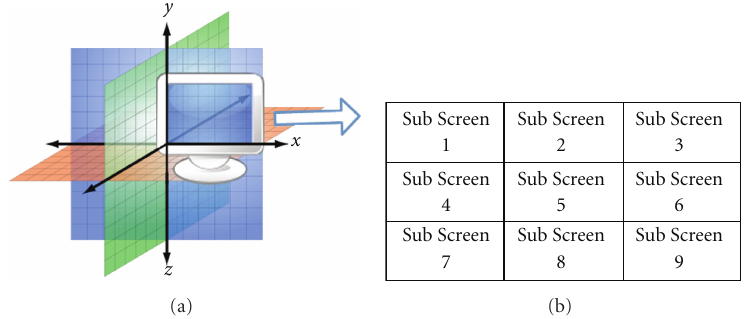
Figure 4: (a) Representation of coordinates system (b) Sub-screen distribution.